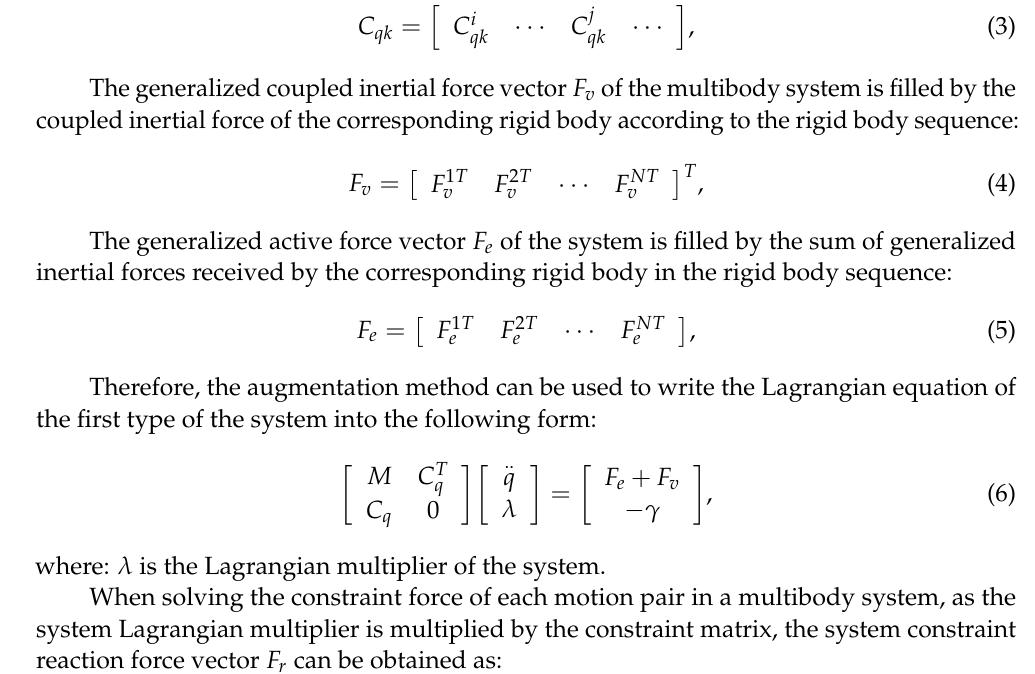
Figure 7. Rigid body removal method from the dynamic equations. 4. Calculation Results of the Variable Topology of Carrier-Based Aircraft Catapult Dynamics Taking the catapult take-off of a carrier-based aircraft (Table 3) as an example, the dynamic response of the catapult of the modified aircraft is calculated by using the cata- pult dynamics model established in this paper. Table 3. Catapult dynamics model parameters. Parameters